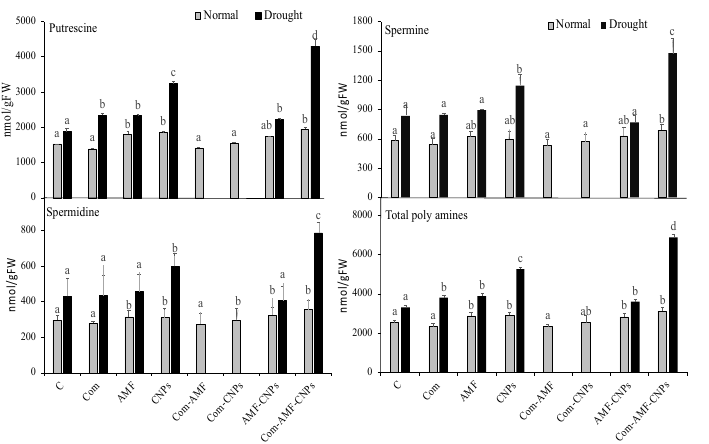
Figure 3. Effect of different treatments on polyamines of maize under control and drought (D) conditions. Different letters indicate statistically significant difference between means for the different treatments at significance level of at least p ≤ 0.05.